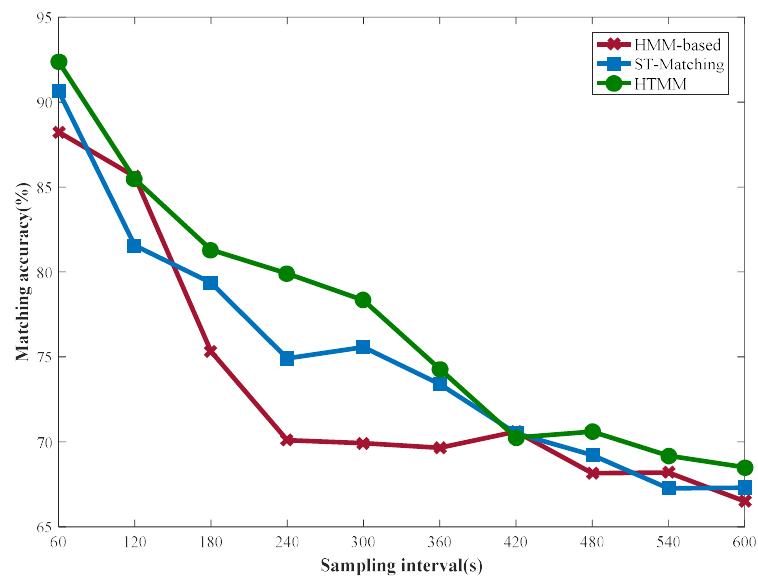
Figure 12. Matching accuracy of three algorithms at different sampling rates.